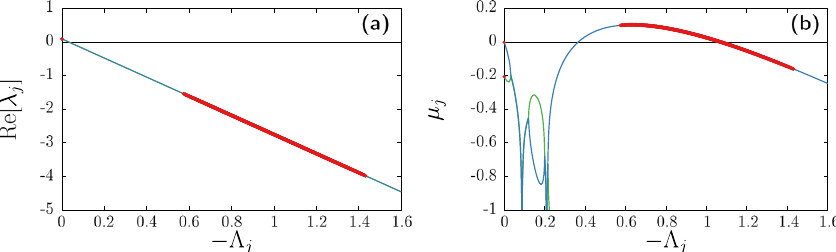
Fig. 1 Dispersion relation for the Brusselator system with Fick ’ s diffusion. Red dots indicate the discrete dispersion relation as obtained by diagonalizing the Laplacian operator (see Methods) corresponding to an Erdös-Rényi network with N = 1000 nodes and average degree 〈 k 〉 = 20. Continuous lines show the continuous dispersion relation associated to a lattice at the thermodynamic limit (see Methods). System parameters of the reactive terms are a = 1.3 and b = 2.5. Diffusion values are D x = 0.7 and D y = 5. a Real part of the eigenvalues λ j controlling the stability of the homogeneous fi xed point as a function of the Laplacian eigenvalues Λ j , j = 1, … , 2 N . b Real part of the Floquet exponents μ j controlling the stability of the homogeneous limit-cycle solution as a function of the Laplacian eigenvalues Λ j , j = 1, … , 2 N . Since we are considering two-dimensional single-node dynamics, blue and green continuous lines show the two different branches of the dispersion relation whenever they are different, such as in b . Notice that with our de fi nition of the Laplacian, the eigenvalues Λ j are non-positive, thus we display − Λ j in the x axis. Other works might use a different de fi